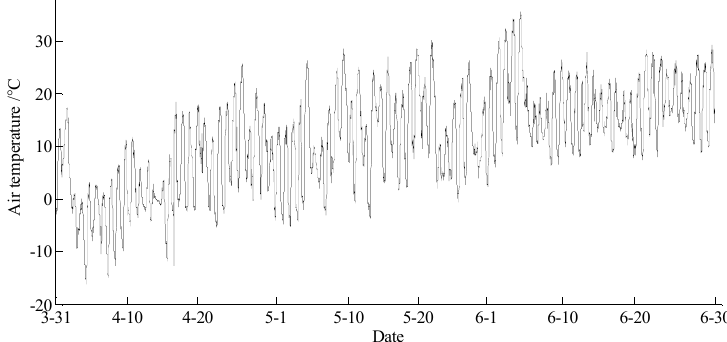
Figure 16. The curve of the air humidity in Hulun Buir.